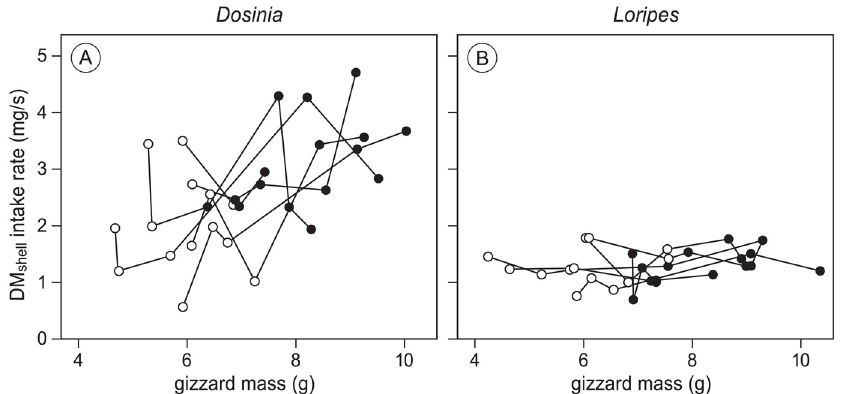
Fig 2. Dry shell mass (DM shell ) intake rate on a Dosinia diet (A) and on a Loripes diet (B). Lines connect all trials of the same bird when it was in the small gizzard group (open dots) and in the large gizzard group (solid dots). Intake of Dosinia was higher for birds with large gizzards, whereas intake of Loripes was not affected by gizzard size (model 2.1 in S1 Table). Loripes intake rate was generally lower than Dosinia intake rate. These results confirm that intake of Dosinia is limited by a digestive constraint, whereas intake of Loripes is limited more stringently, presumably by its toxic load, and independent of gizzard mass.